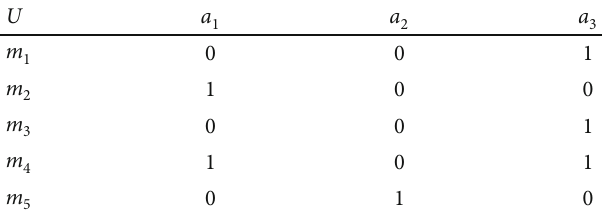
Table 1: Representation of the soft set ð F , A Þ .